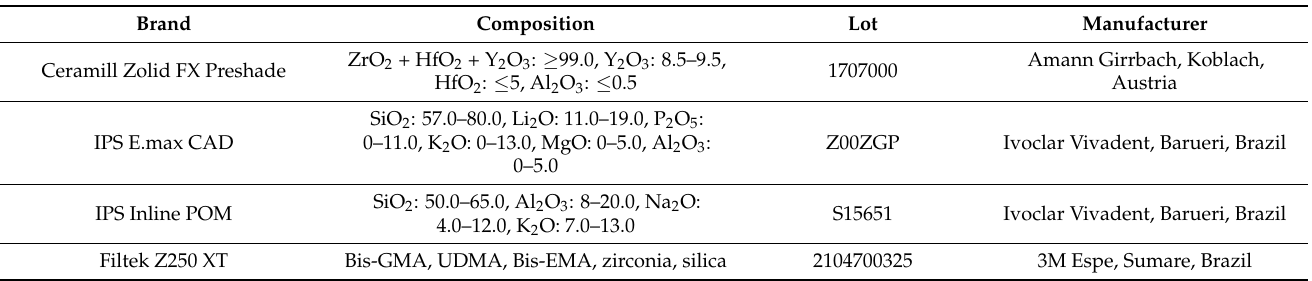
Table 1. Brand, composition, lot, and manufacturer of materials used in this in vitro